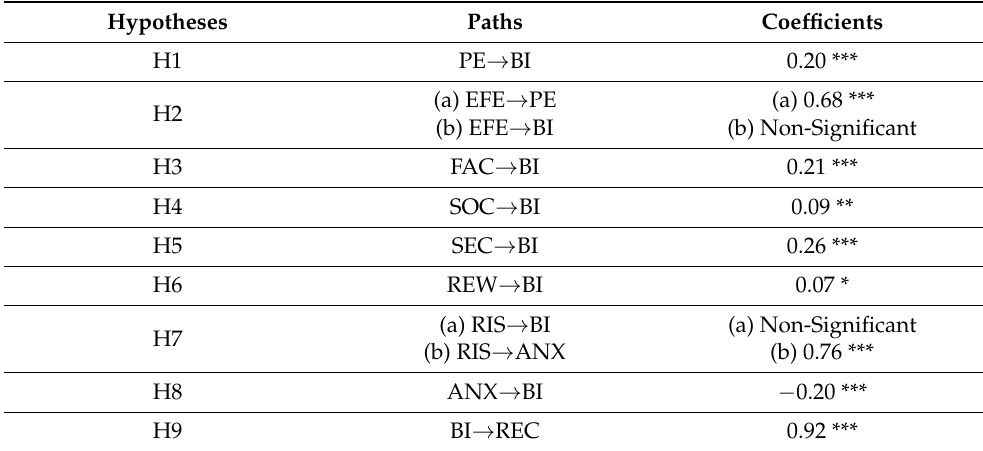
Table 7. Path coefficients—Users. p < 0.1, * p < 0.05, ** p < 0.01, *** p <